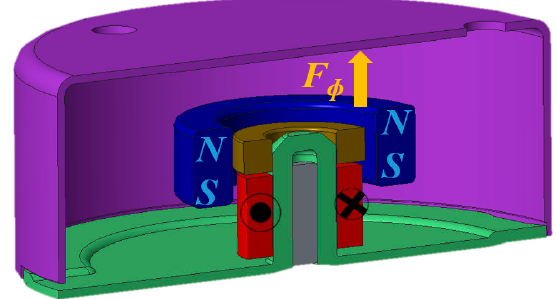
Figure 2. Model used for electrical and magnetic simulation.